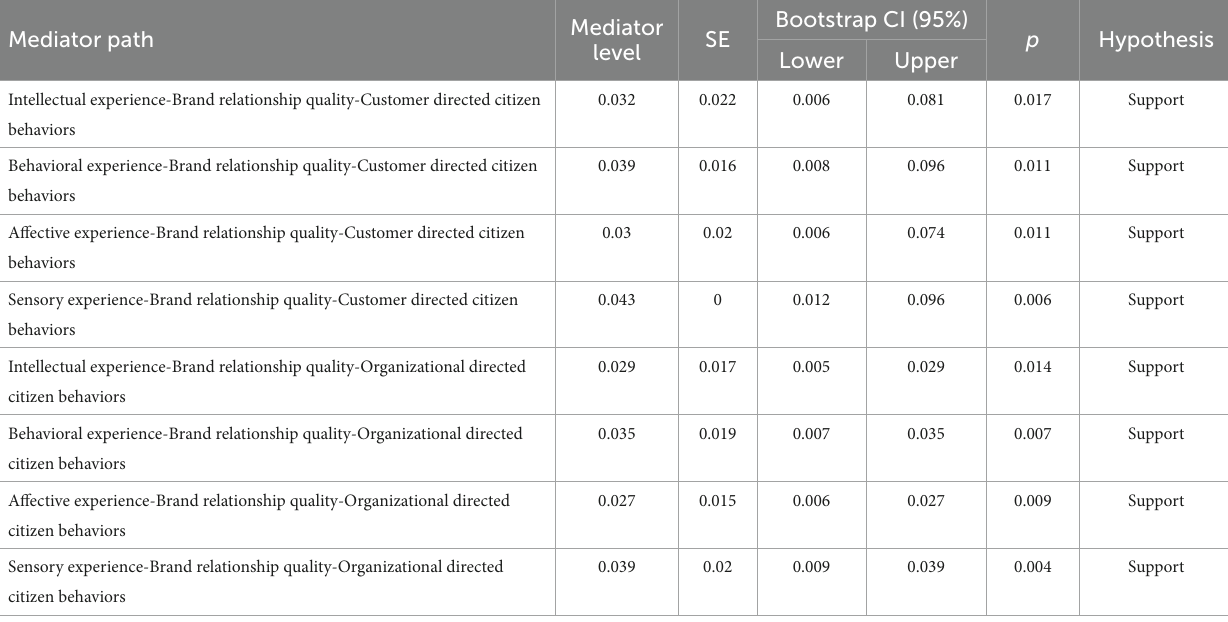
TABLE 7 Mediator variable